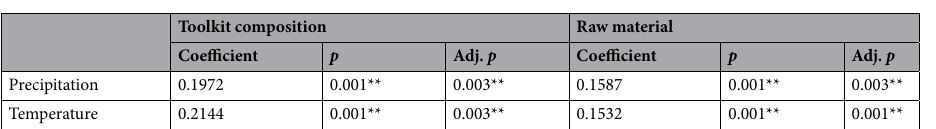
Table 1. Simple Mantel test results for the effects of precipitation and temperature on toolkit composition and raw material. Statistical significance highlighted at p < 0.05 (*) or p < 0.01 (**). The Benjamini–Hochberg procedure was used to adjust p